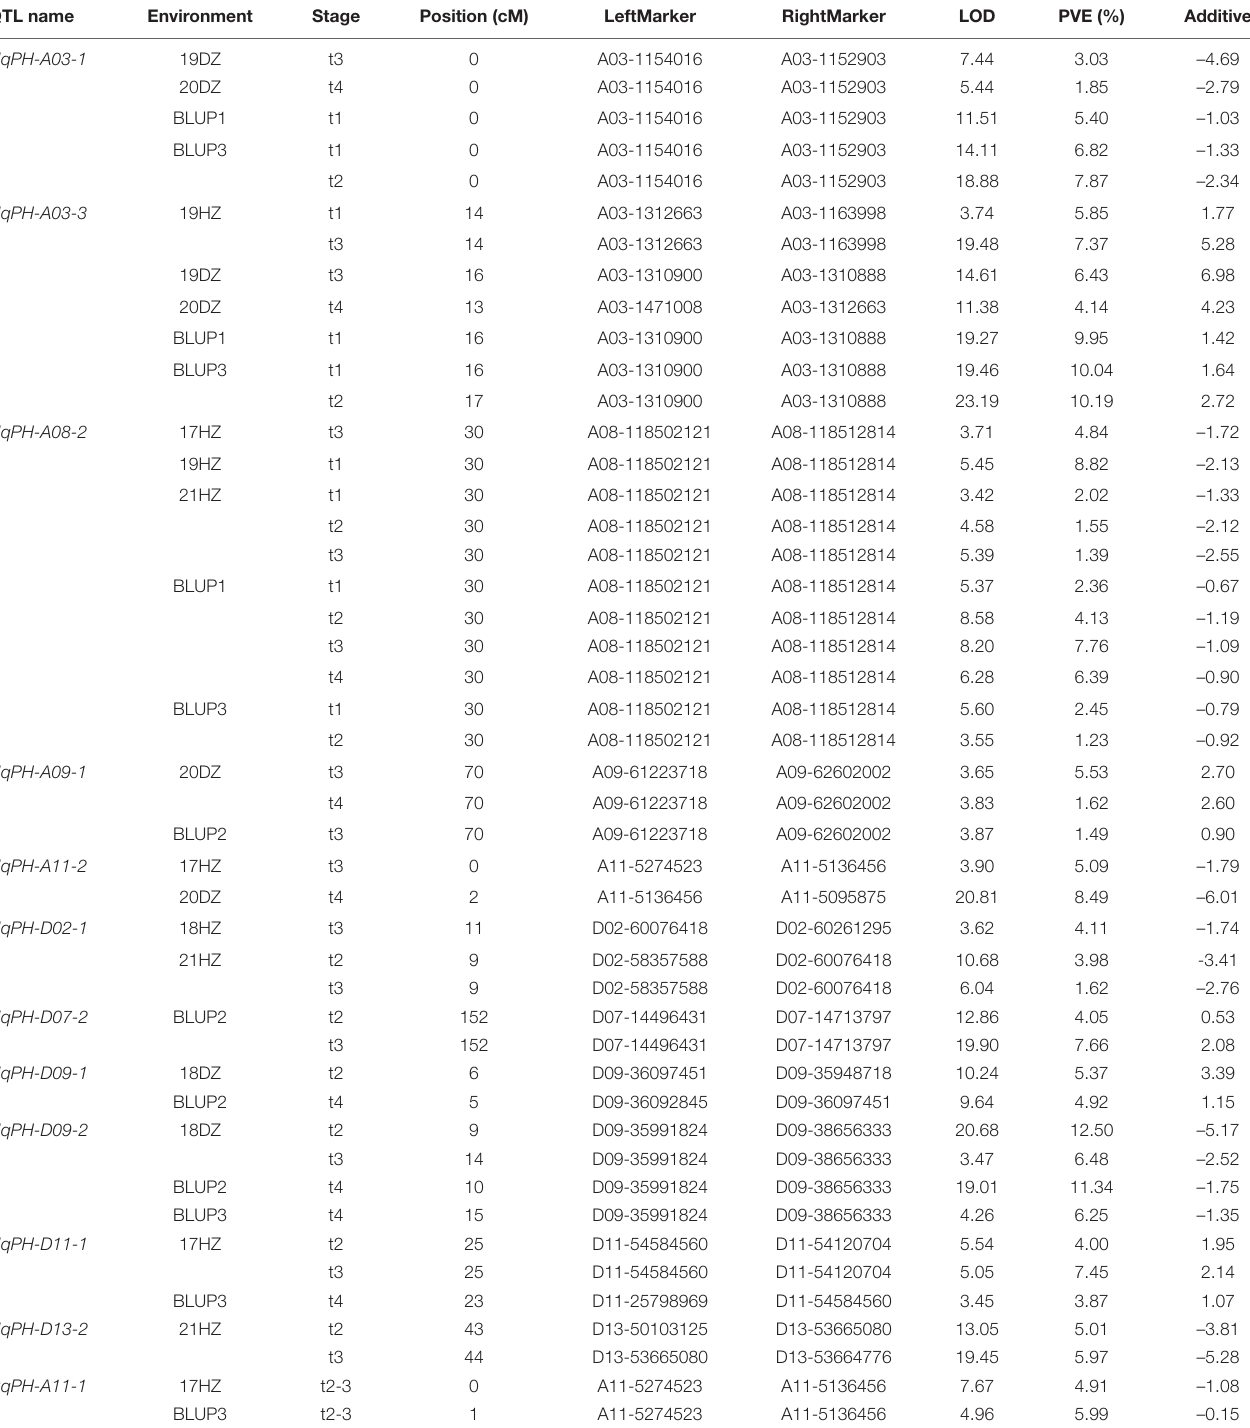
TABLE 2 | Major and stable quantitative trait loci (QTL) detected for plant height in different